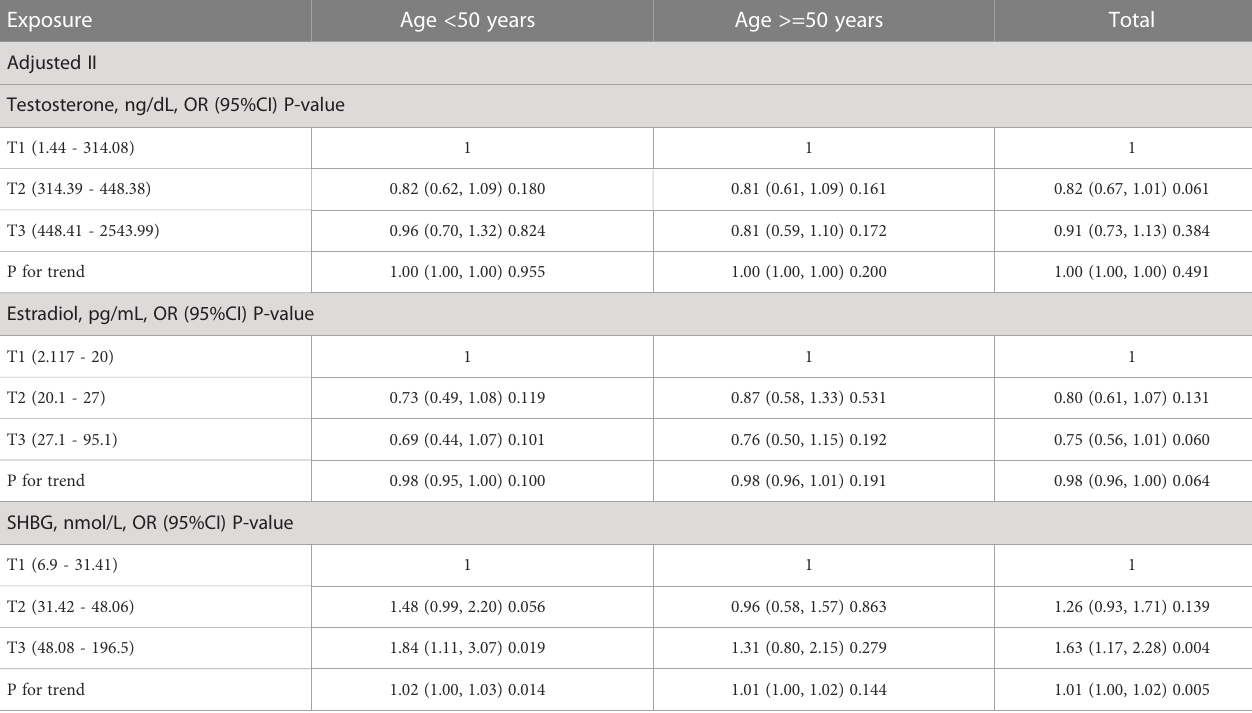
TABLE 4 The subgroup analysis of age for the association of sex hormone levels and periodontitis in males.